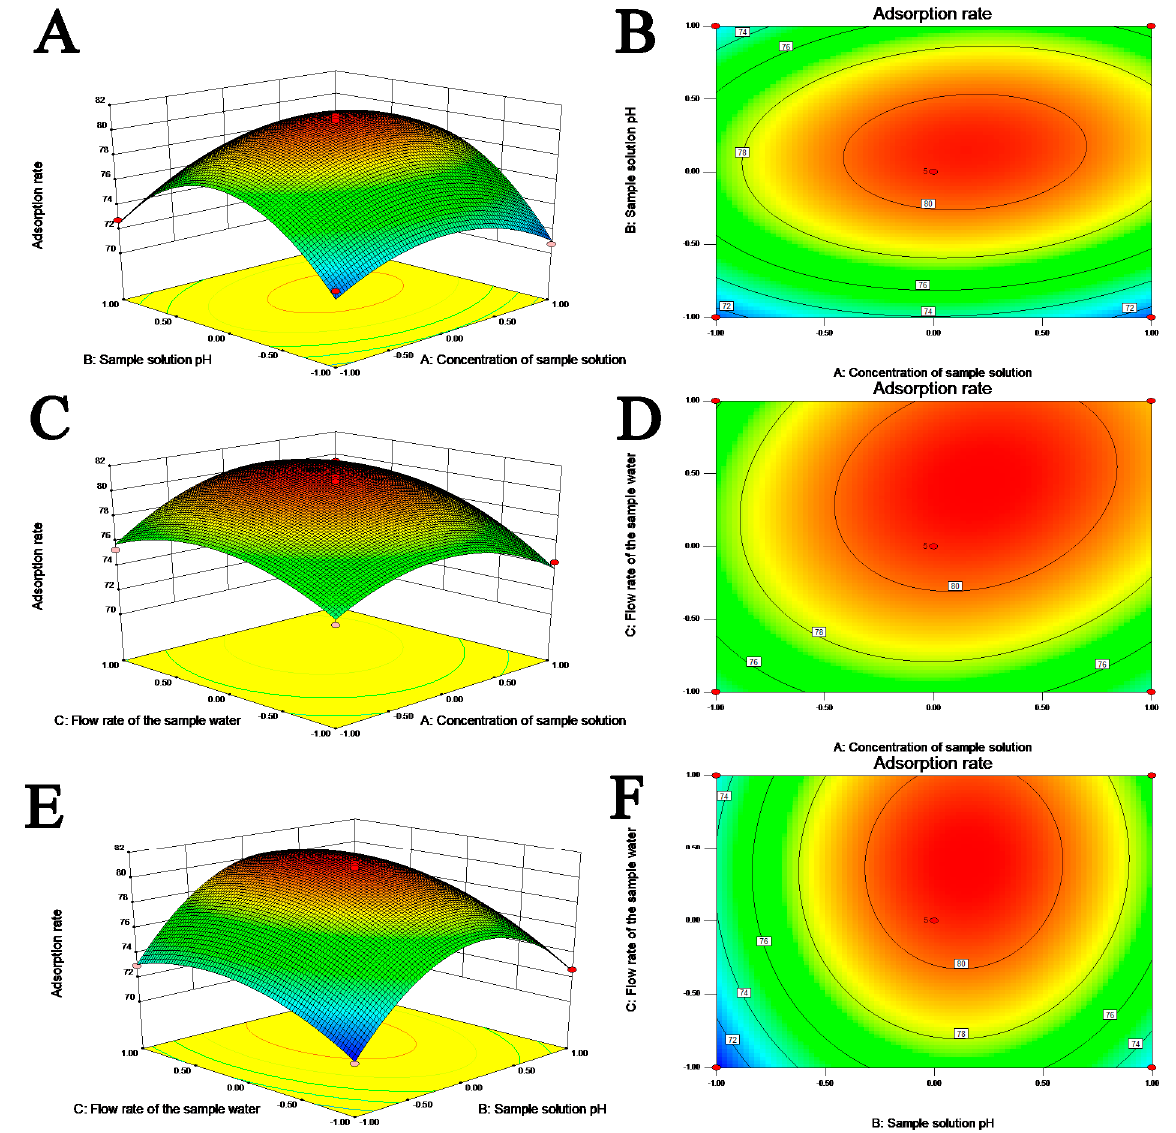
Figure 5. 3D response surface plots ( A , C , E ) and contour plots ( B , D , F ) showing the effects of interac- tions on the naringin purification conditions; ( A , B ), concentration of sample solution and sample solution pH; ( C , D ), concentration of sample solution and flow rate of the sample water; ( E , F ), sample solution pH and flow rate of the sample